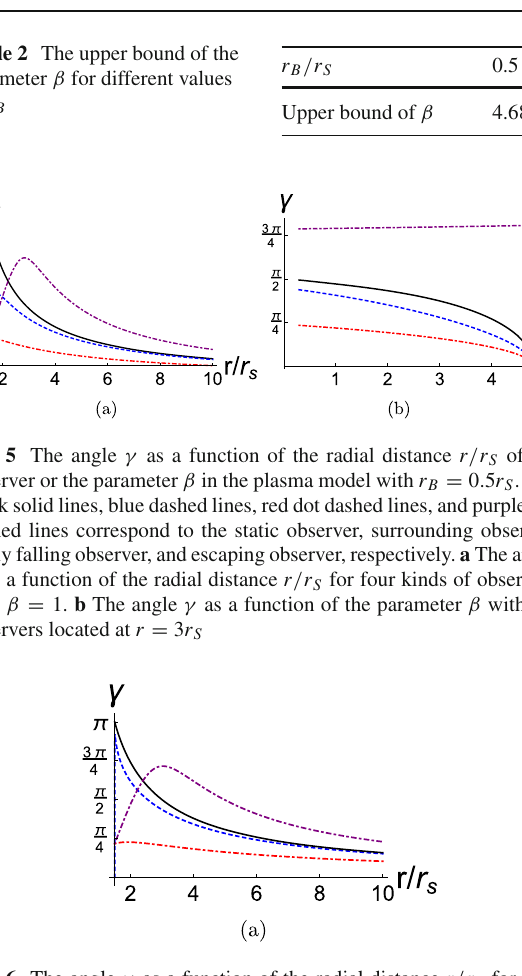
Fig. 6 The angle γ as a function of the radial distance r / r S for four kinds of observers in the plasma model with β = 0 . 01. The black solid lines,bluedashedlines,reddotdashedlines,andpurpledotdashedlines correspond to the static observer, surrounding observer, freely falling observer, and escaping observer, respectively